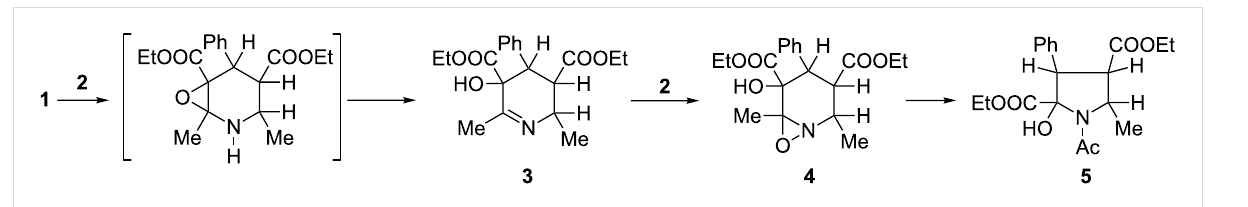
Scheme 2: Heterocycle transformations of 1 in air saturated CHCl 3 solutions.